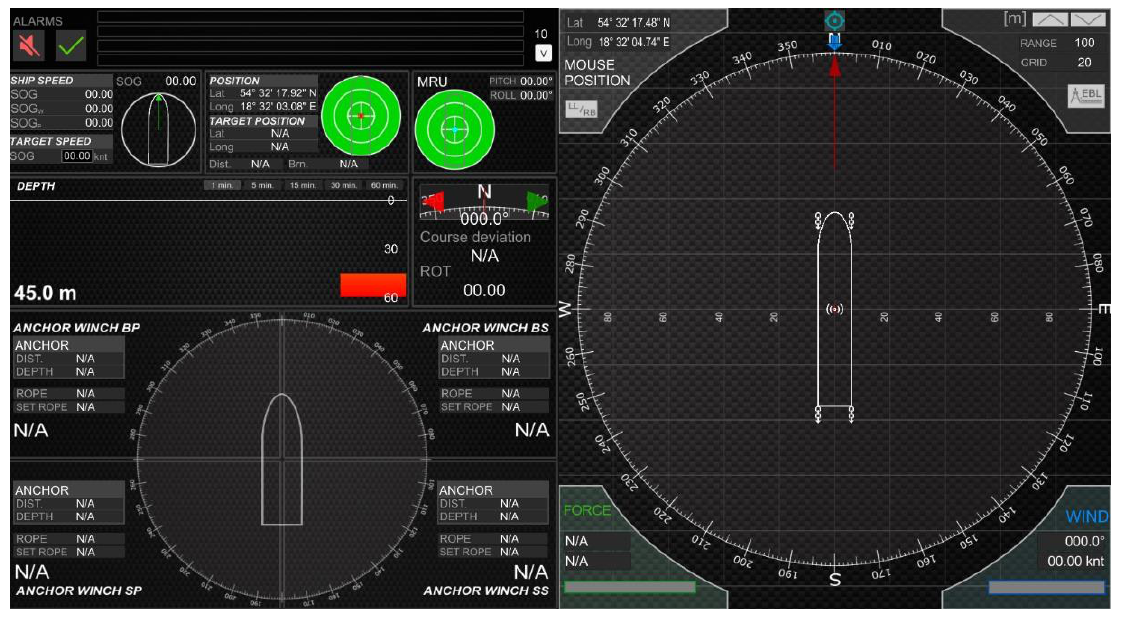
Figure 6. User interface developed in Unity3d.